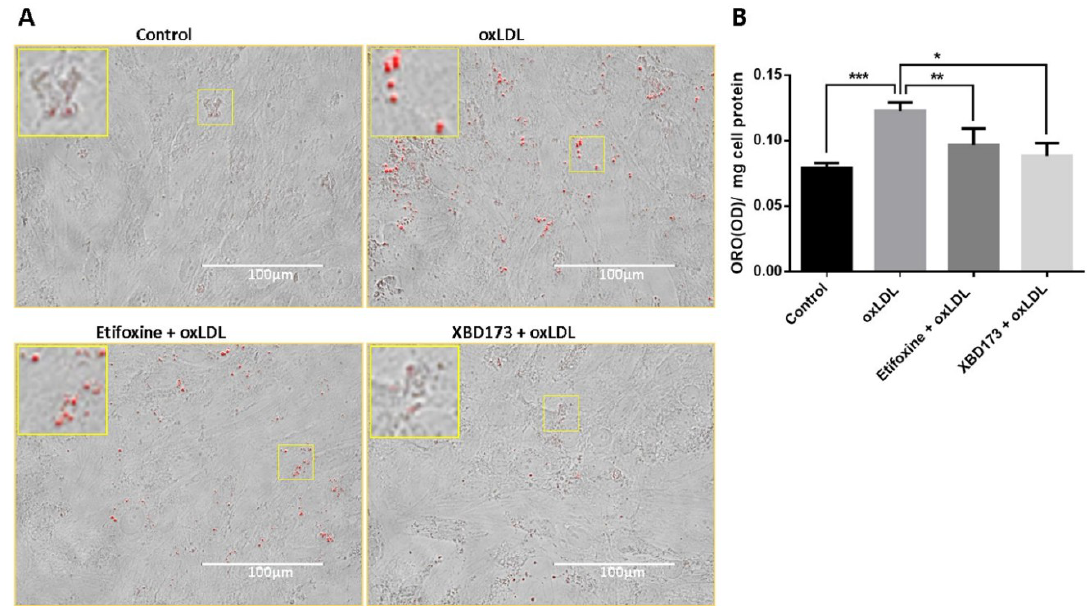
Figure 4. Lipid droplets were detected in RF6A cells by Oil Red O (ORO) staining after treatment with oxLDL and with oxLDL + TSPO ligands. The oxLDL-treated cells were compared to cells treated with Etifoxine (20 μM) + oxLDL or with XBD173 (25 μM) + oxLDL and to vehicle-treated controls. The cells were then fixed with 10% formalin and stained with ORO and images were captured by EVOS microscopy ( A ). Inserts show a 2.5× magnification of the selected regions. The lipid droplets were eluted with 100% isopropanol and optical density (OD) at 520 nm was measured using a plate absorbance reader. The OD was normalised with respect to total cell protein. The data were analysed using one-way ANOVA followed by Bonferroni test and presented as mean ± SD ( B ). * p ≤ 0.05, ** p < 0.01, and *** p < 0.001.